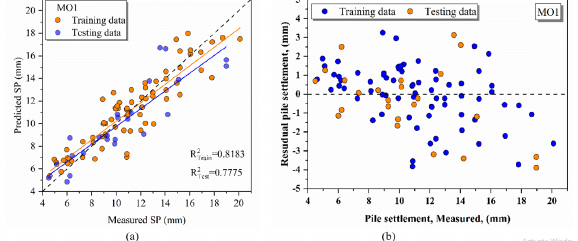
Fig. 5. Comparison between measured and predicted the pile settlement using MO1 for training and testing data (a) model prediction, and (b) residual pile settlement Eq. (11)